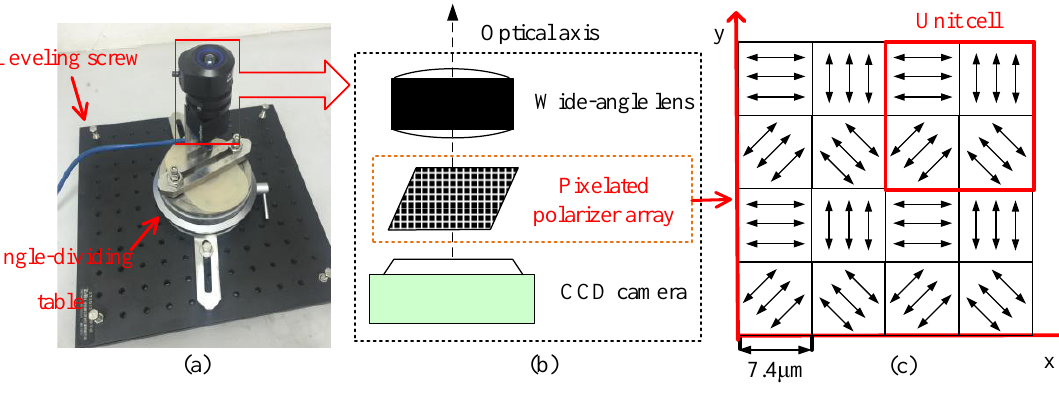
Figure 1. ( a ) the pixelated polarized light compass; ( b ) the installing structure of the sensor; ( c ) layout design of the pixelated